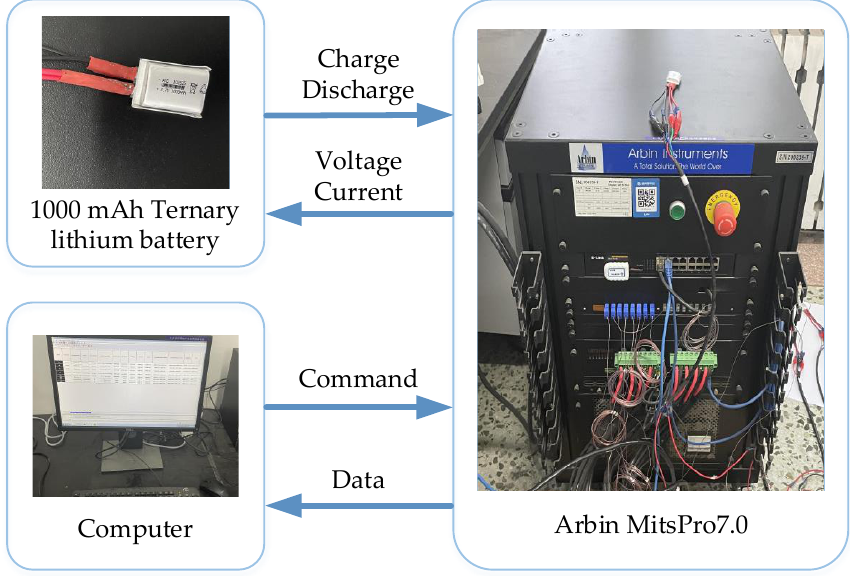
Figure 6. Battery testing system.